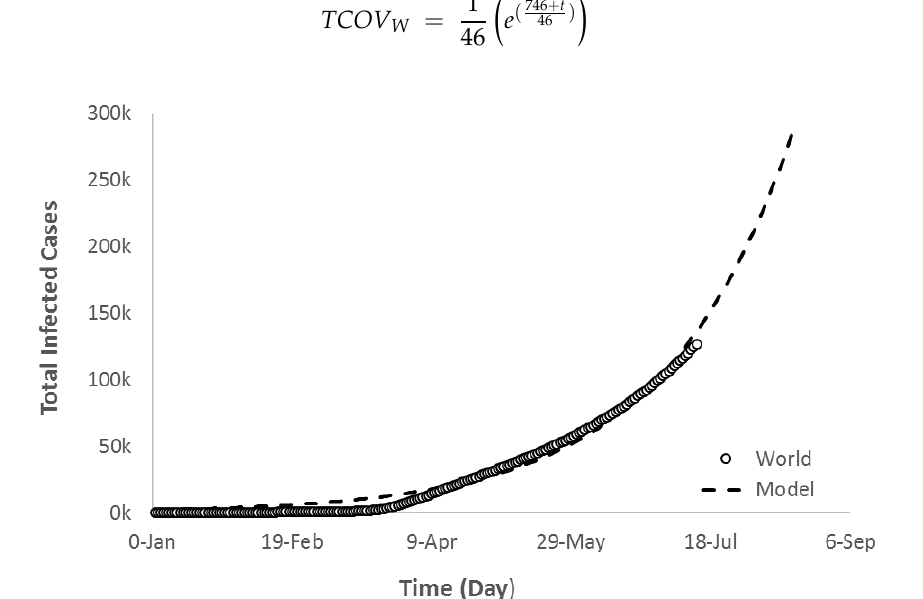
Figure 14. Exponential growth regression fit of the world’s current and future trajectory of COVID-19 total infected cases.